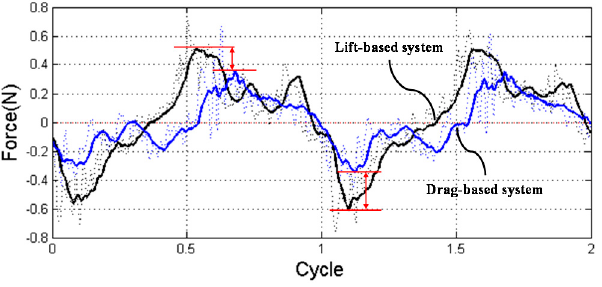
Figure 22. Horizontal force comparison between drag-based system and lift-based system at hovering.